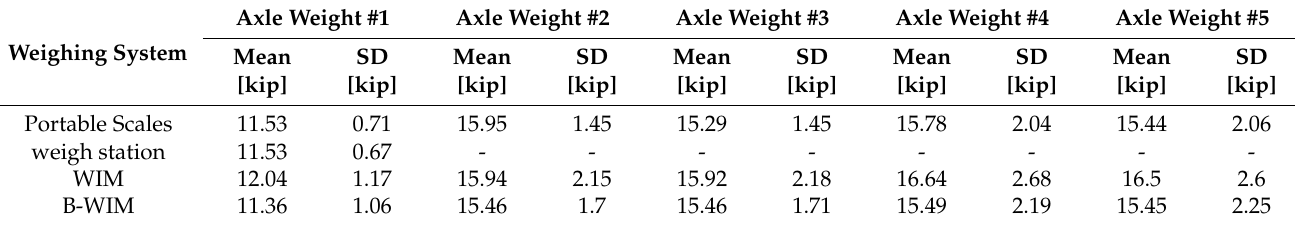
Table 4. Statistical parameters of Axle weight for all weighing